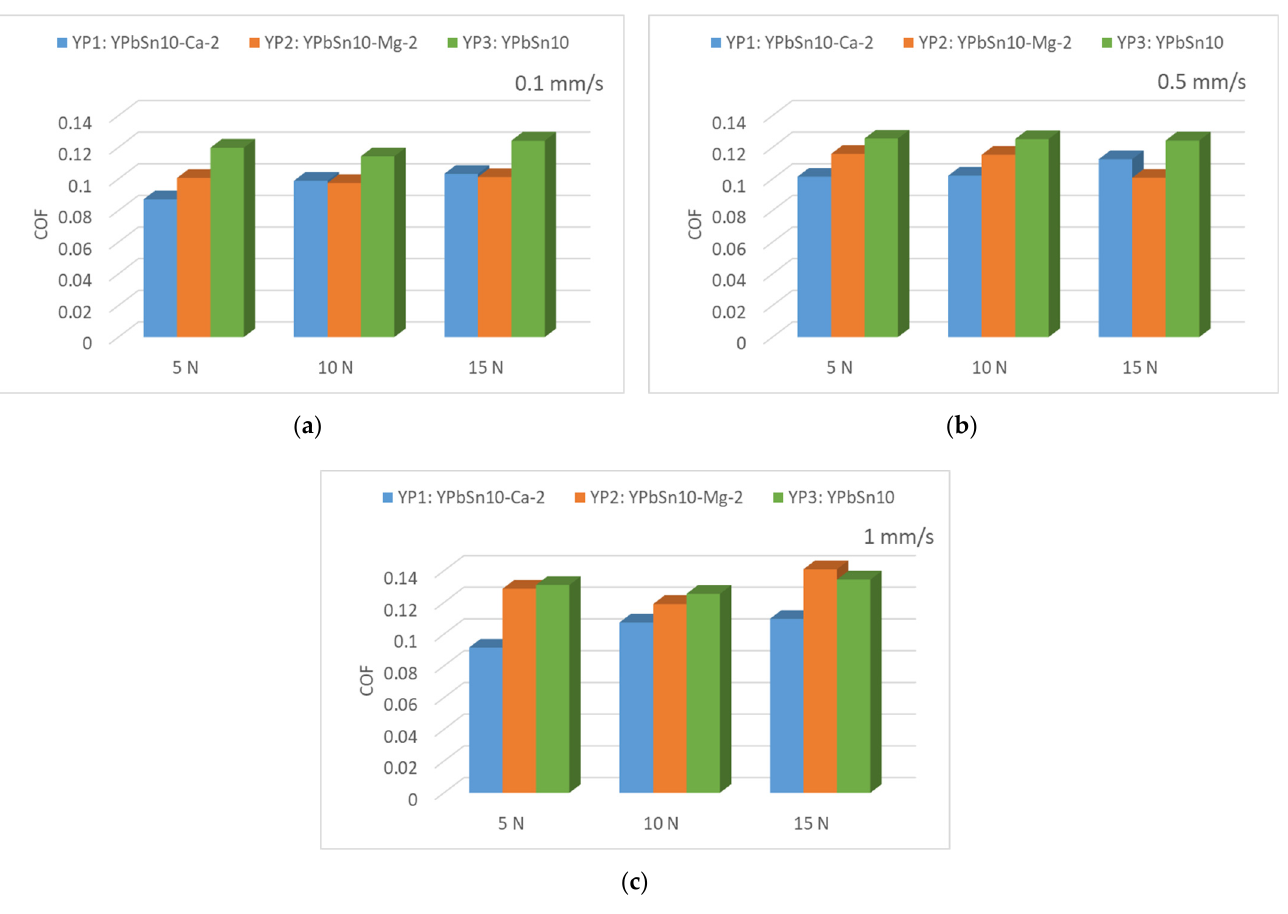
Figure 10. Average values of the friction coefficient: ( a ) Comparison for the 0.1 mm/s sliding speed; ( b ) comparison for the 0.5 mm/s sliding speed; ( c ) comparison for the 1 mm/s sliding speed.